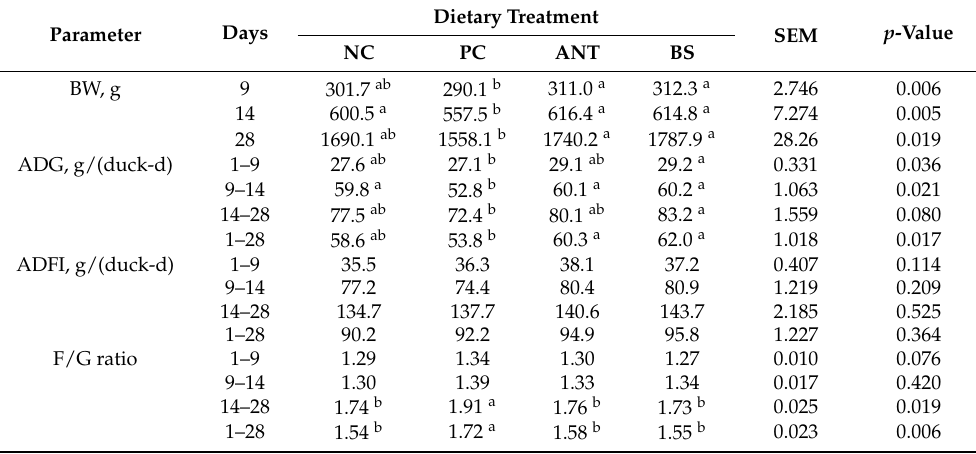
Table 1. Effect of B. subtilis on growth performance of ducks challenged with E. coli .